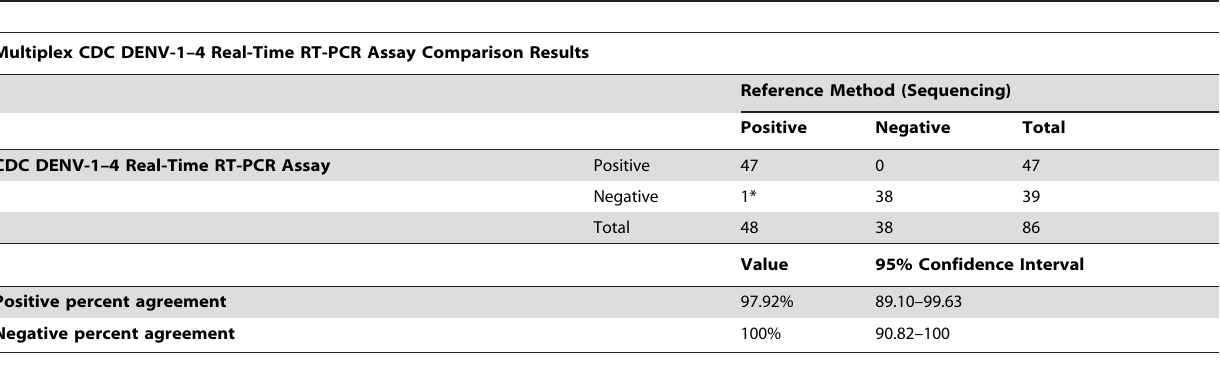
Table 7. Agreement between CDC DENV-1–4 Real Time RT-PCR and sequencing in samples from suspected dengue